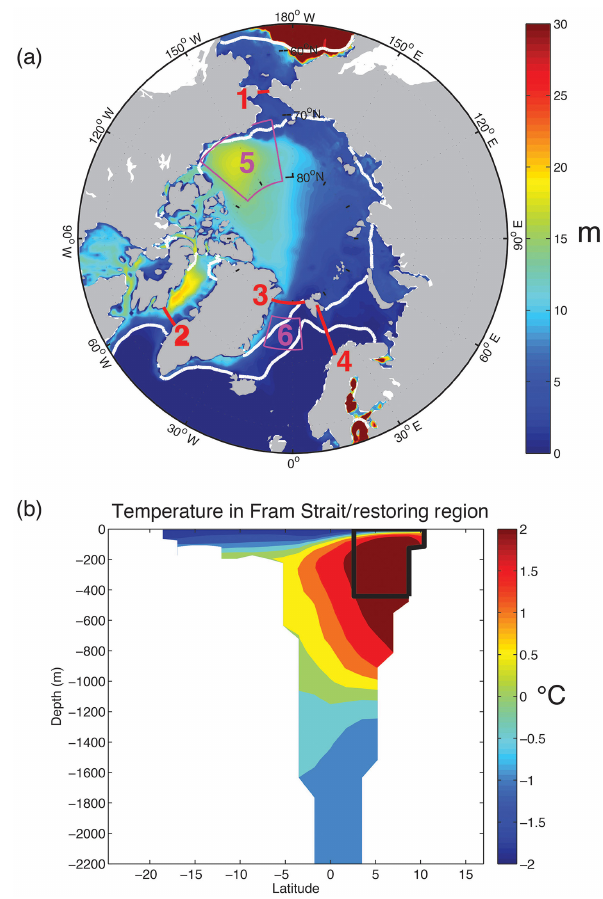
Figure 2. (a) Average FWC (freshwater content) over the pe- riod 1979–2013 (colored, in meters) from the MITgcm simula- tion. The summer (inner white lines) and winter sea-ice extent (outer white lines) are plotted. Key sections and regions are num- bered: 1 = Bering Strait, 2 = Baffin Bay–Davis Strait, 3 = Fram Strait, 4 = Barents Sea Opening, 5 = Beaufort Gyre region, and 6 = Greenland Sea region. (b) Annual-mean temperature section through the Fram Strait looking northward in to the Arctic. The black box indicates the region where inflow parameters are mod- ified in the calculations